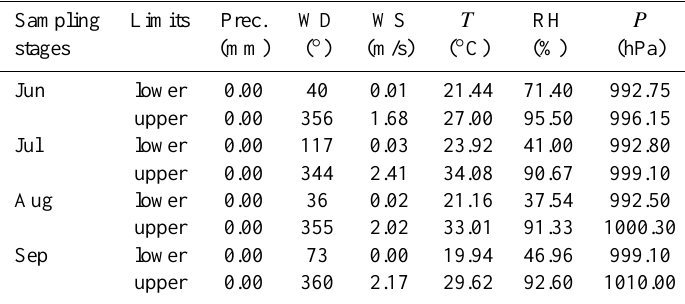
Table 3. Summarize of the statistical results of the meteorological condition in the four sampling stages. Sampling